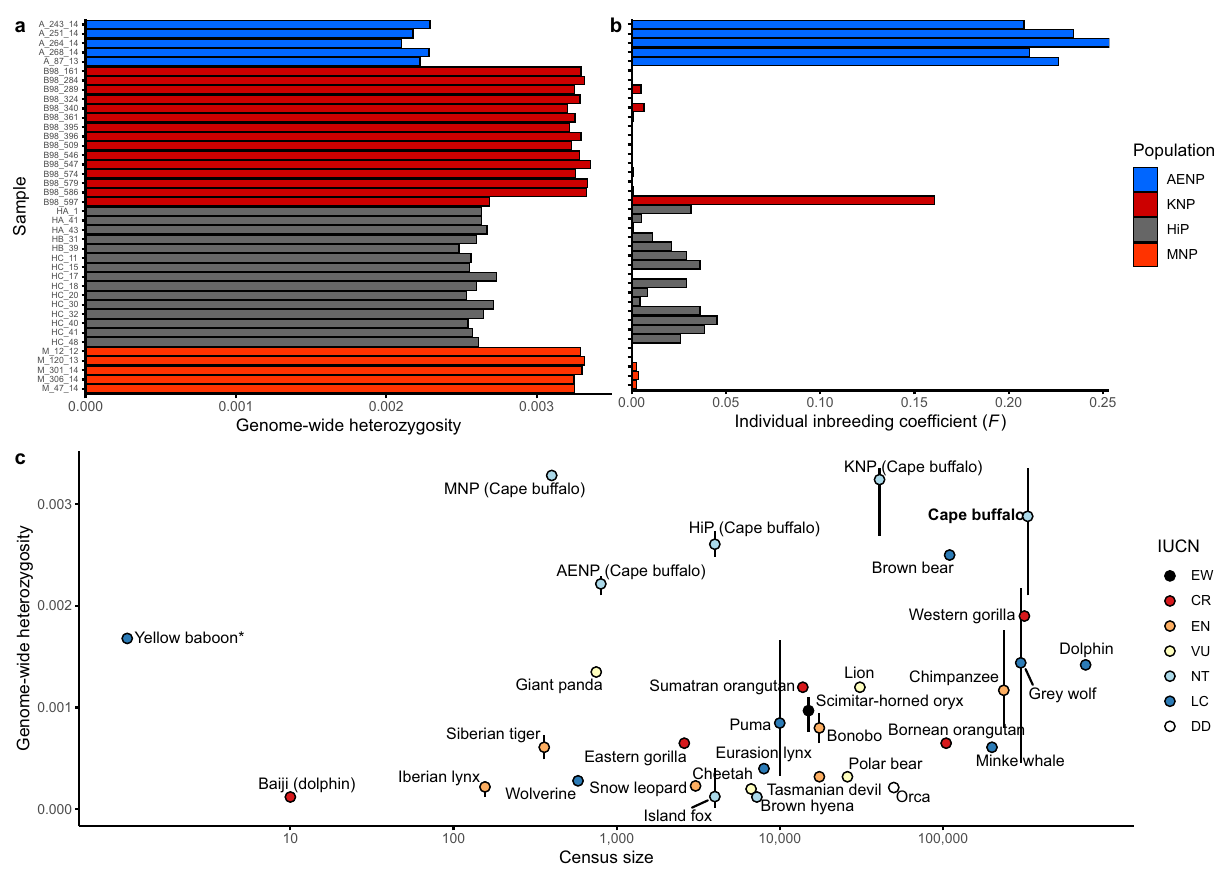
Figure 2. Genome-wide diversity indices. ( a ) Individual genome-wide heterozygosity estimates for each sample (-GL 1 Samtools). ( b ) Individual inbreeding estimates ( F ) for each sample. ( c ) Genome-wide heterozygosity of mammalian species plotted against census size. Colours indicate IUCN Red List categories as on 03/08/2020. The vertical bars indicate the range of heterozygosity across multiple individuals, where available. The mean and range across all Cape buffalo samples in this study is shown (bold face), as well as the mean and range for each population. The range for MNP is plotted, but is too narrow to extend beyond the plotting point. *No estimate of census size is available for the yellow baboon; thus, it was plotted at a value of 1 to still be included in the figure. The figure was adapted from Ekblom et al. 44 Data for a, b and c are provided in Supplementary Tables 6 and Genomic diversity and inbreeding. The comparison of the two genotype likelihood models in ANGSD, namely Samtools (-GL 1) and GATK (-GL 2), showed substantially higher heterozygosity estimates were obtained for all samples with the GATK method (Supplementary Fig. 1), which does not account for error in its implementation in ANGSD. Given that the Samtools method does account for error, this model was used in all subsequently reported heterozygosity estimates, as well as in the estimation of long-term N e . The comparison of heterozygosity between subsampled BAM files, to determine the effect of low coverage data on this measure, showed the lowest heterozygosity for the low coverage data (25% of reads subsampled), higher heterozygosity for the medium coverage data (50% of reads subsampled) and the highest value was obtained when no reads were subsampled (Supplementary Fig. 2). Individual genome-wide heterozygosity estimates (Fig. 2a) were significantly higher in the Kruger National Park (KNP) and Mokala National Park (MNP) compared to Hluhluwe-iMfolozi Park (HiP, p -values = 5.16e−8 and 1.29e−4) and Addo Elephant National Park (AENP, p -values = 1.29e−4 and 7.94e−3). Heterozygosity was also significantly higher in HiP compared to AENP ( p -value = 1.29e−4), while that observed in MNP was statistically equivalent to the heterozygosity of KNP ( p -value = 0.866). One individual from KNP, B98_597, had substantially lower genome-wide heterozygosity than other individuals from KNP (Fig. 2a, Supplementary Table 6). Cape buffalo had significantly higher genome-wide heterozygosity compared to all species included in Fig. 2c, except the brown bear and the grey wolf, for which heterozygosity estimates overlapped with those of Cape buffalo (Fig. 2c, Supplementary Table 7). The populations KNP and MNP had higher heterozygosity than all other spe- cies included in Fig. 2c. Buffalo from AENP had high individual inbreeding coefficients ( F ) (0.21–0.25, Fig. 2b, Supplementary Table 6). Individuals from HiP had inbreeding coefficients close to zero, despite having relatively lower levels of genome-wide heterozygosity compared to KNP and MNP. Individuals from KNP and MNP also had inbreeding coefficients close to zero, except for sample B98_597 for which F = 0.16.